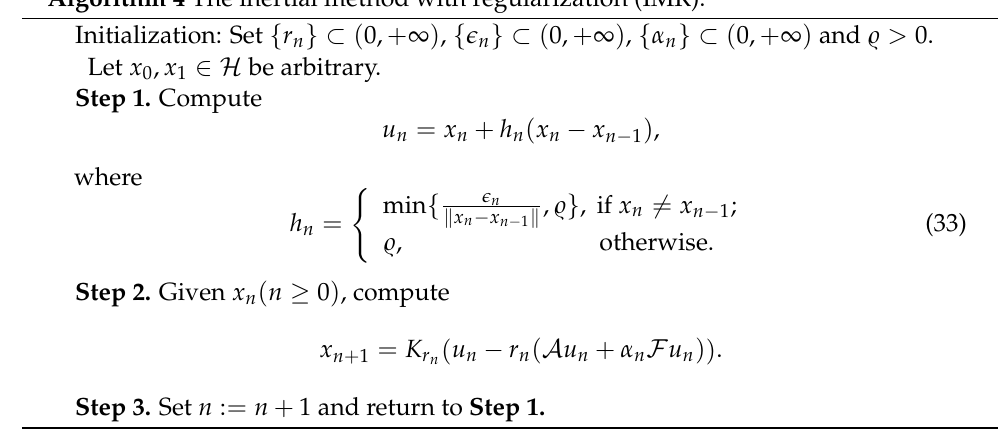
Algorithm 4 The inertial method with regularization